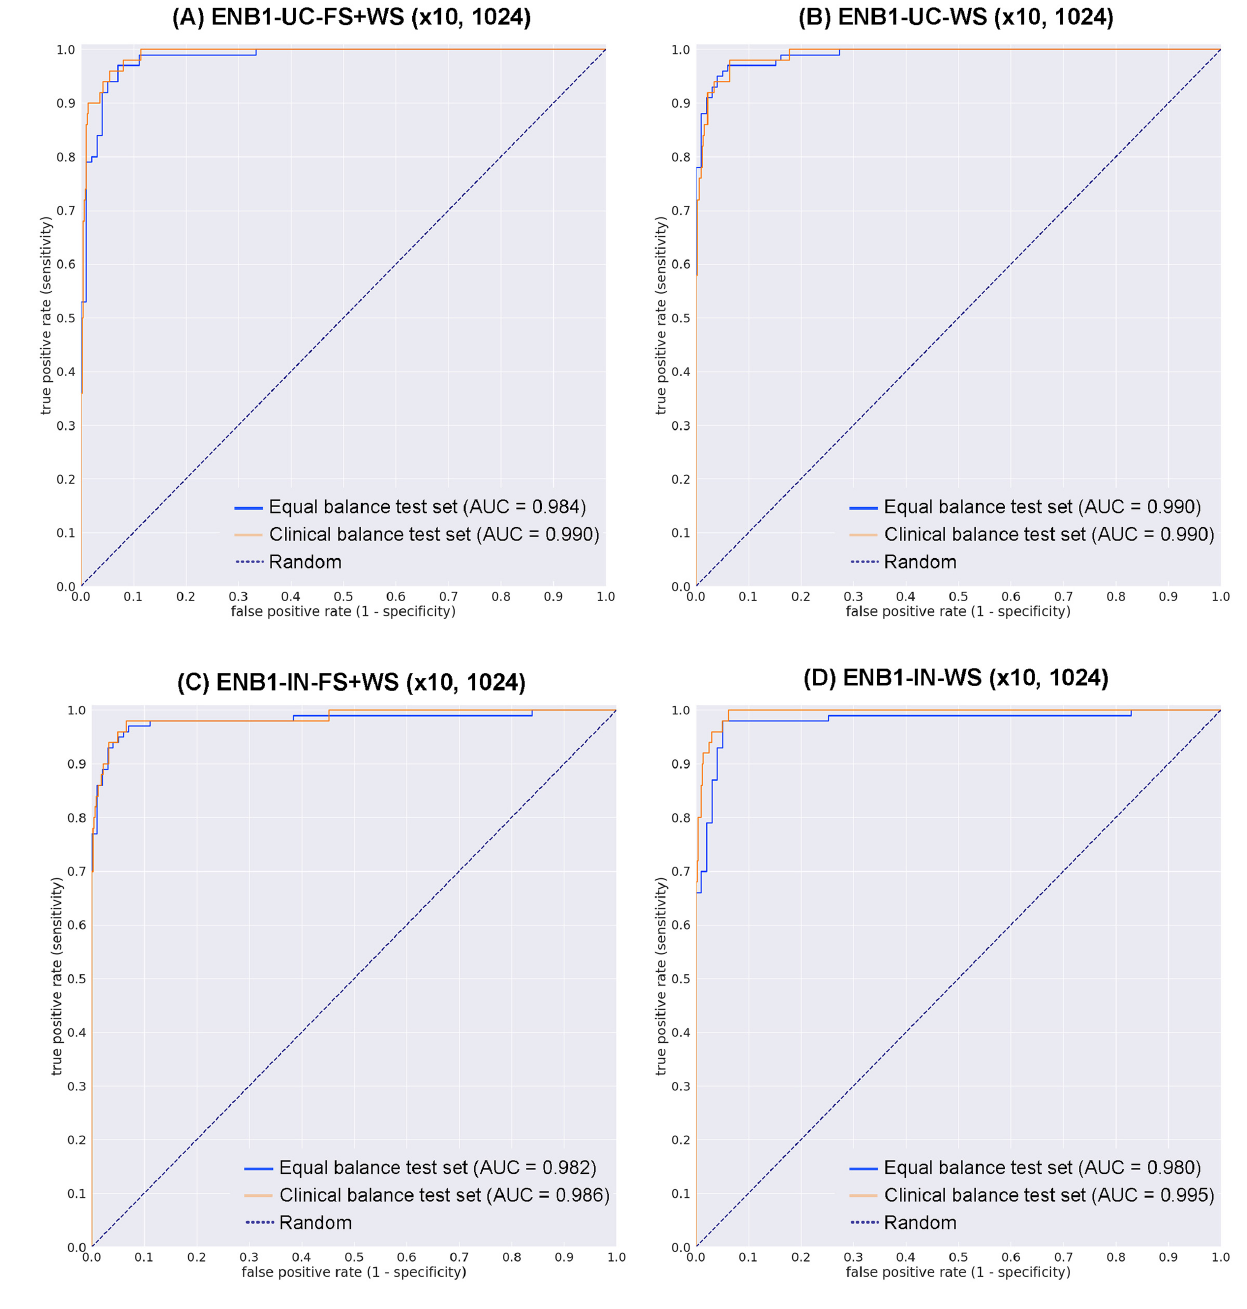
Figure 3. ROC curves on the test sets. ( A ) transfer learning (TL) from uterine cervix liquid-based cytology (LBC) model and fully and weakly supervised learning model, magnification at × 10 and tile size at 1024 × 1024 px (ENB1-UC-FS+WS ( × 10, 1024)); ( B ) TL from uterine cervix LBC model and weakly supervised learning model, magnification at × 10 and tile size at 1024 × 1024 px (ENB1-UC-WS ( × 10, 1024)); ( C ) EfficientNetB1 based fully and weakly supervised learning model, magnification at × 10 and tile size at 1024 × 1024 px (ENB1-IN-FS+WS ( × 10, 1024)); ( D ) EfficientNetB1 based weakly supervised learning model, magnification at × 10 and tile size at 1024 × 1024 px (ENB1-IN-WS ( × 10,